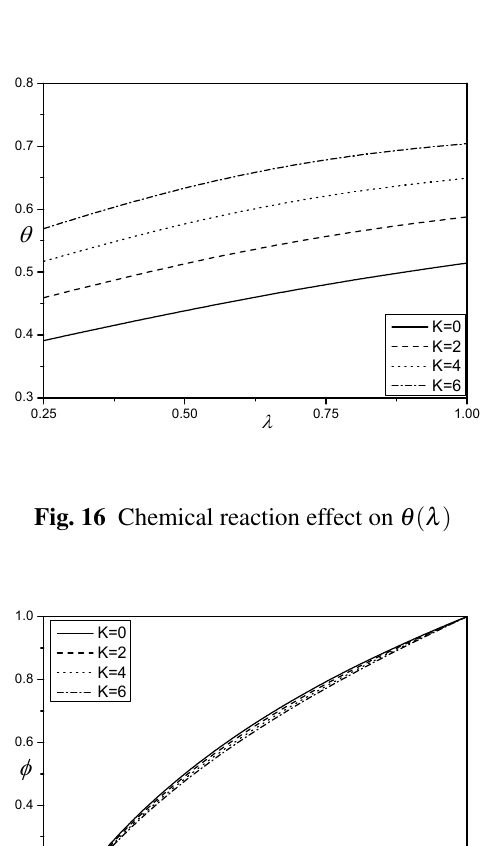
Fig. 15 Chemical reaction effect on f ( λ )